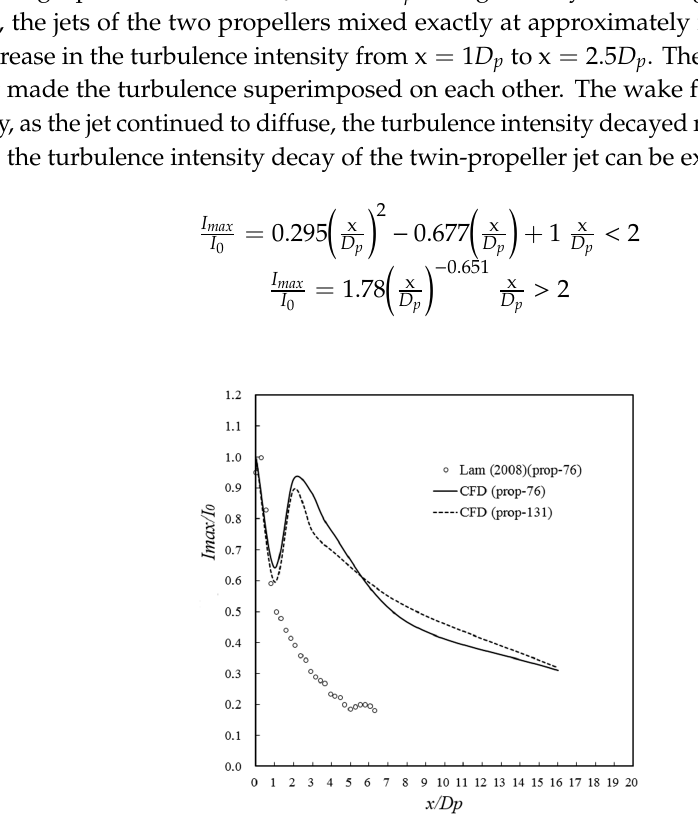
Figure 16. Turbulence intensity decay.